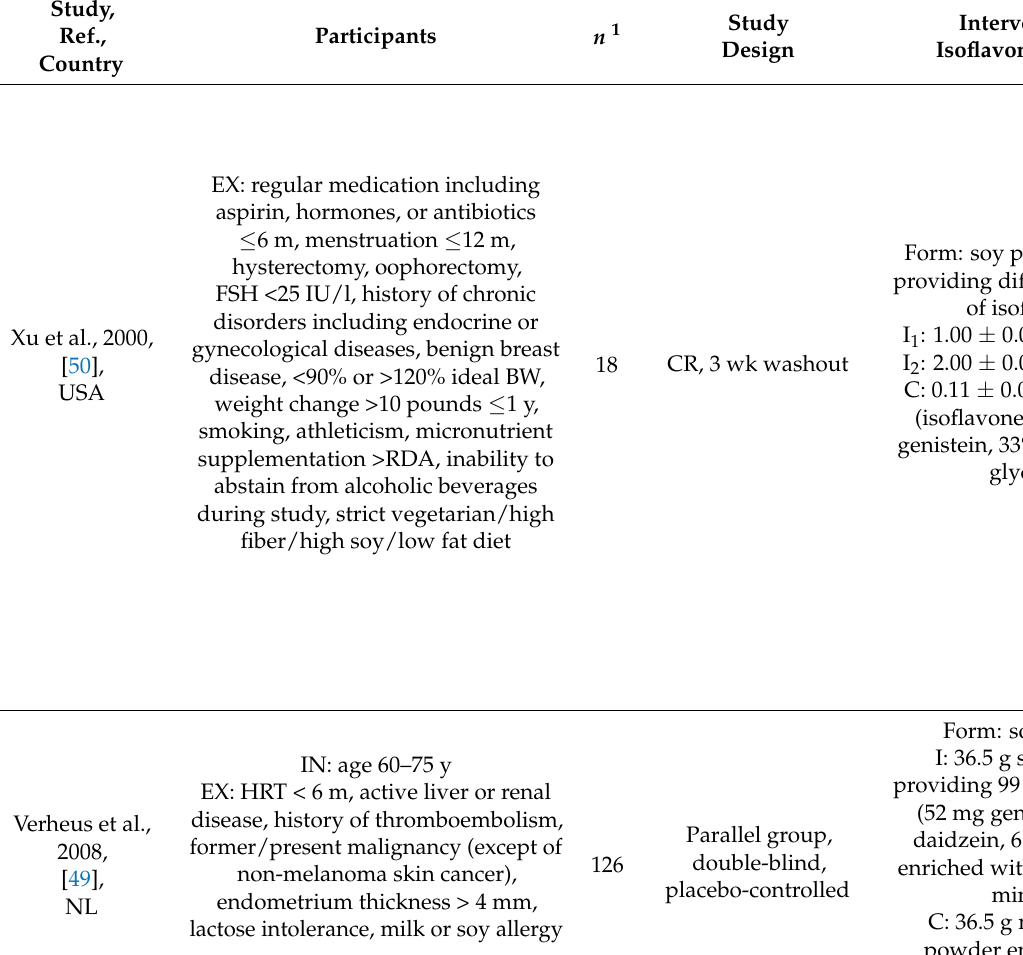
Table 2. Effects of isoflavones intake in postmenopausal women on parameters related to the risk of breast cancer.